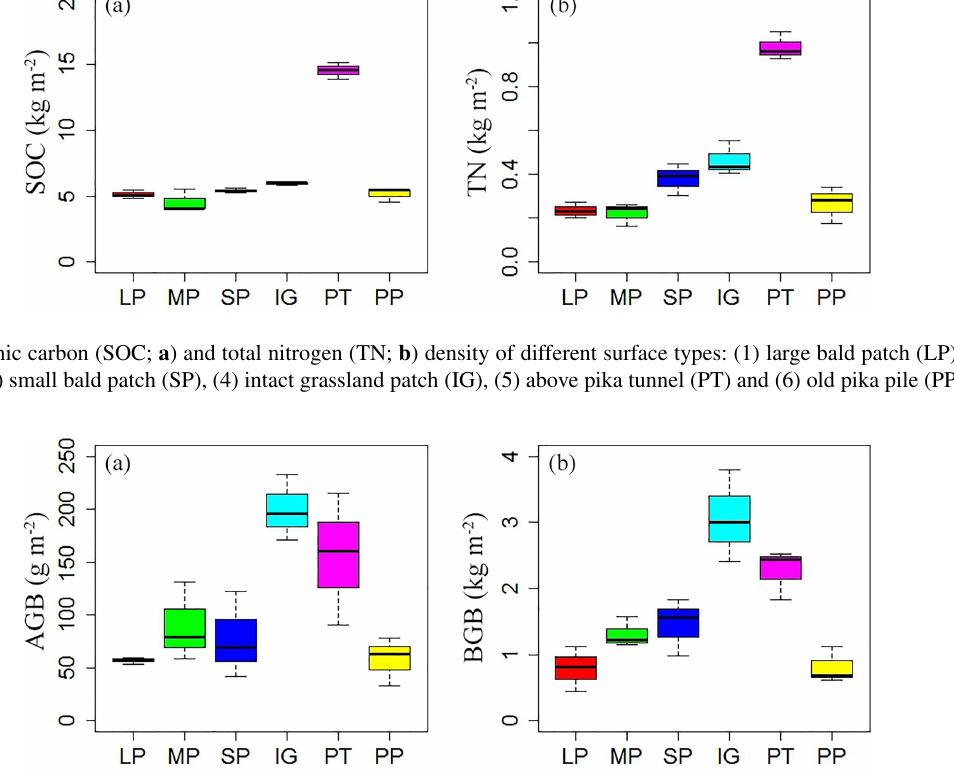
Figure 8. Aboveground biomass (AGB) (a) and belowground biomass (BGB) (b) in different surface types: (1) large bald patch (LP), (2) medium bald patch (MP), (3) small bald patch (SP), (4) intact grassland patch (IG), (5) above pika tunnel (PT) and (6) old pika pile